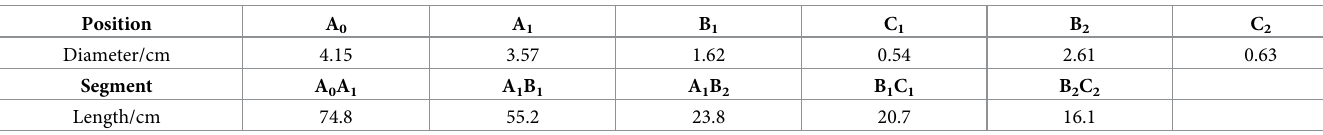
Table 1. The main parameters of the Ginkgo biloba